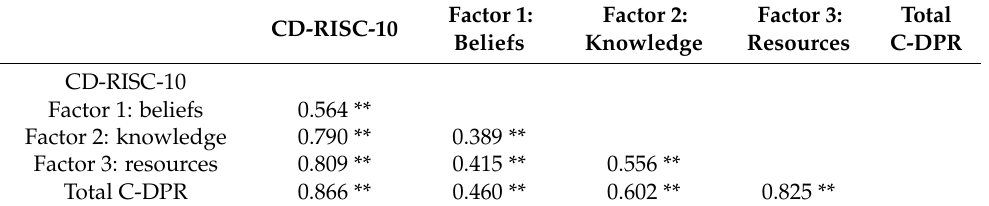
Table 5. Correlations (Pearson r) between CD-RISC-10 and C-DPR.